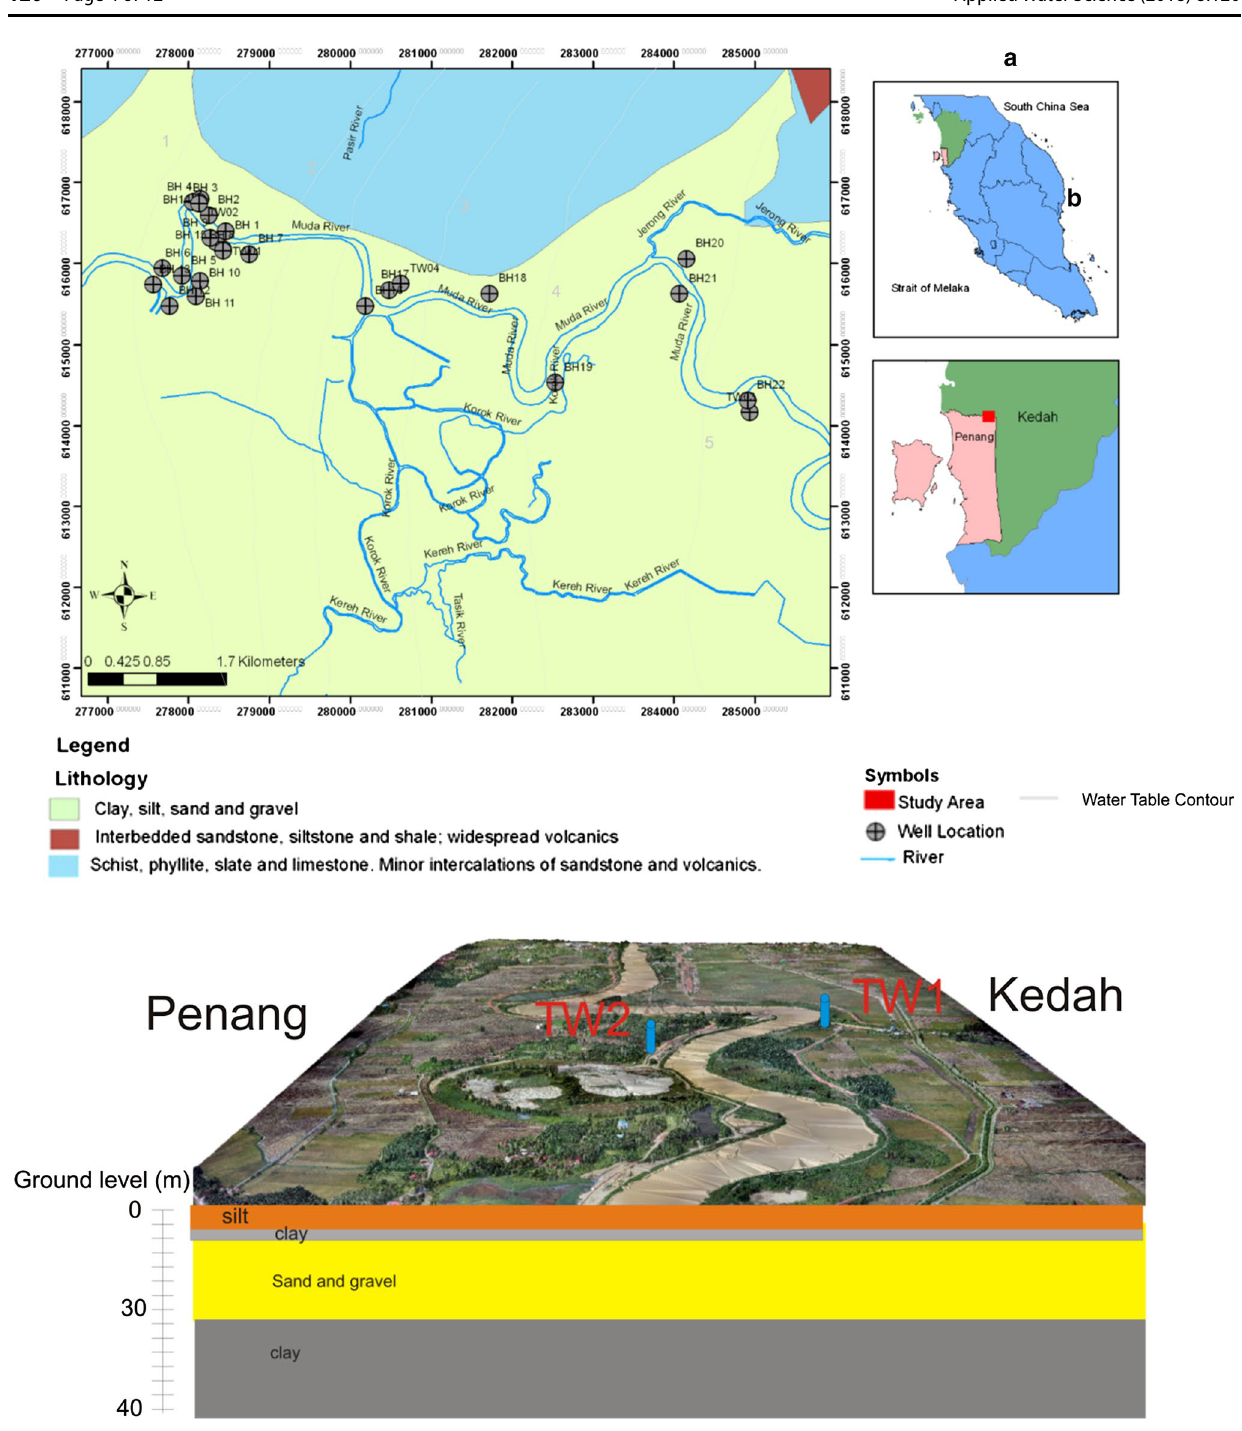
Fig. 1 a Location of the study area within states of Penang and Kedah and b schematic diagram of Riverbank Filtration (RBF) project at Penang and Kedah